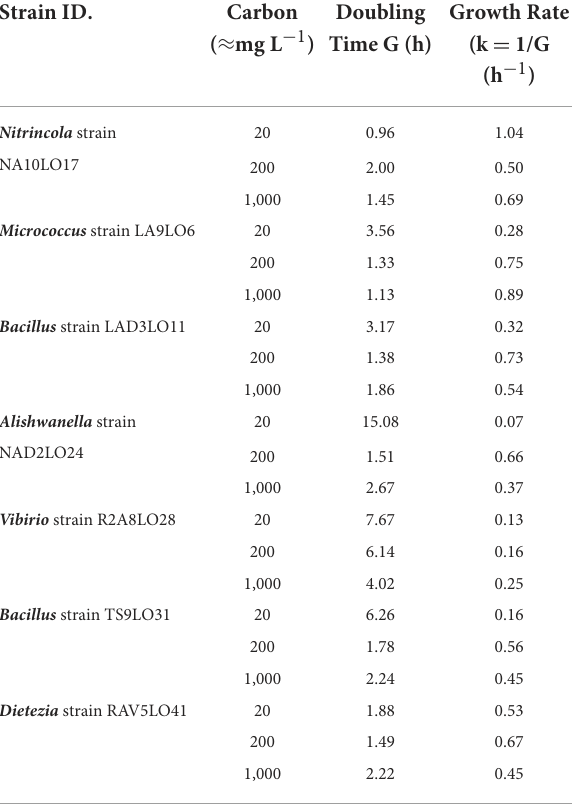
TABLE 4 Doubling time (G) and growth rate (k) of selected facultative oligotrophs on different carbon levels. Strain